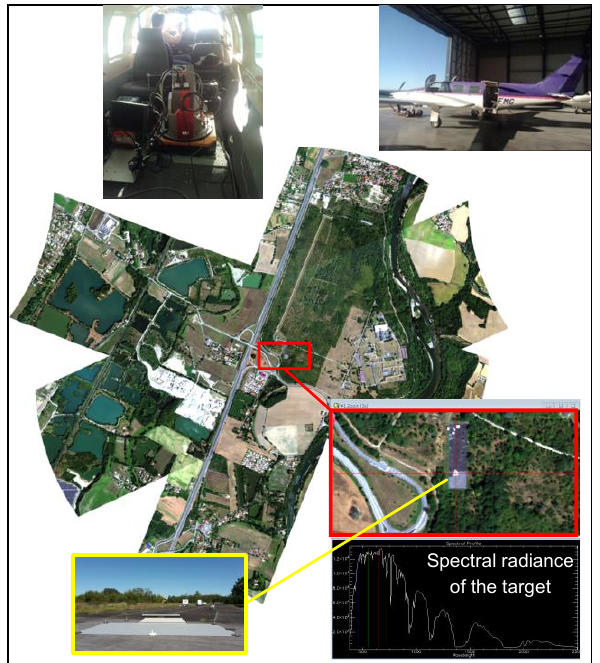
Figure 11. Hyperspectral data acquisition with AISA Fenix 1k on PA-31 of